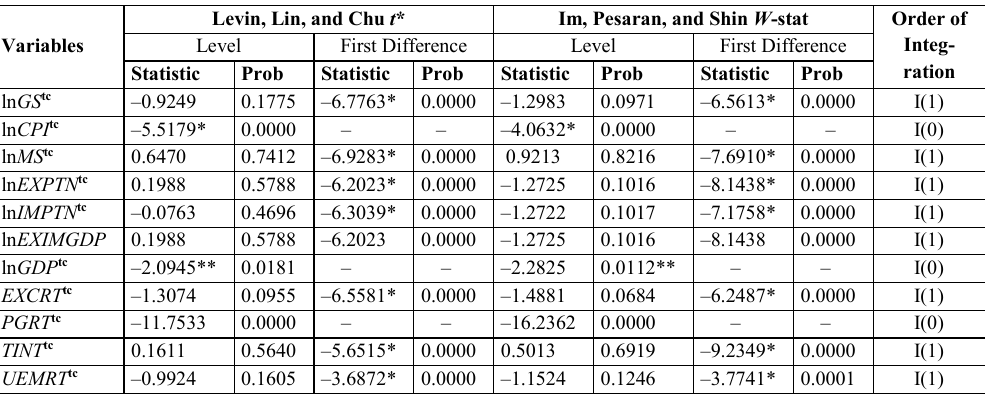
Table 2. Result of LLC and IPS Panel Unit Root Tests